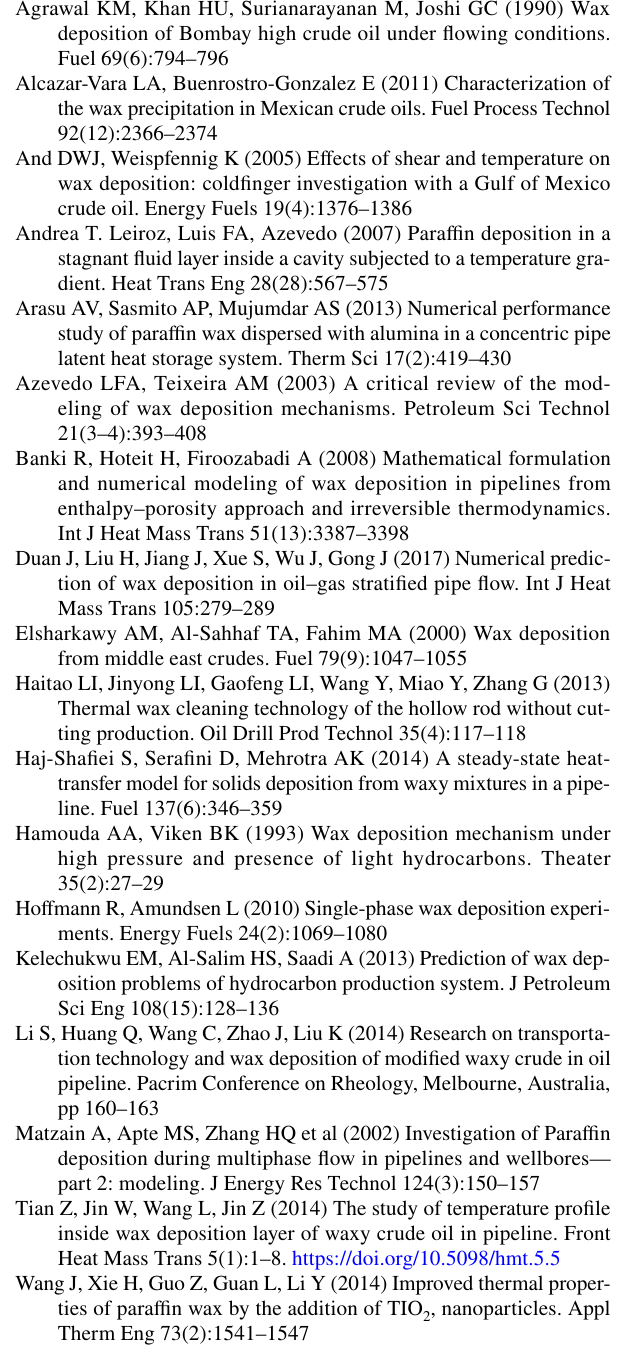
The coincidence rate of predicted and actual results is in the range of